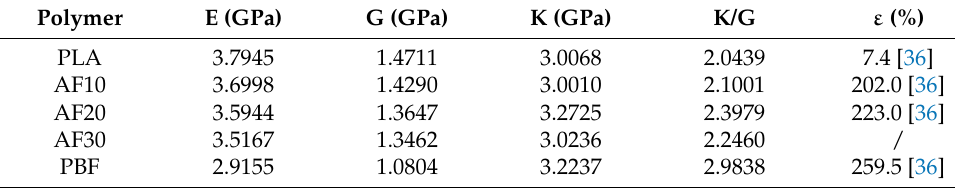
Table 3. Mechanical properties of neat PLA and neat PBF and polymer